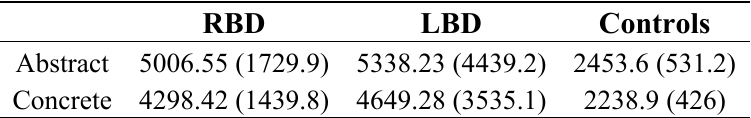
Table 4. Raw RT values for abstract and concrete words in the three groups of participants. SD are reported in